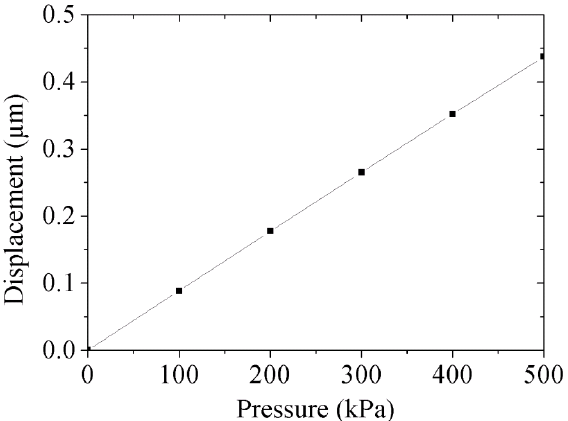
Figure 5. Relation between pressure and displacement at the center of the membrane.